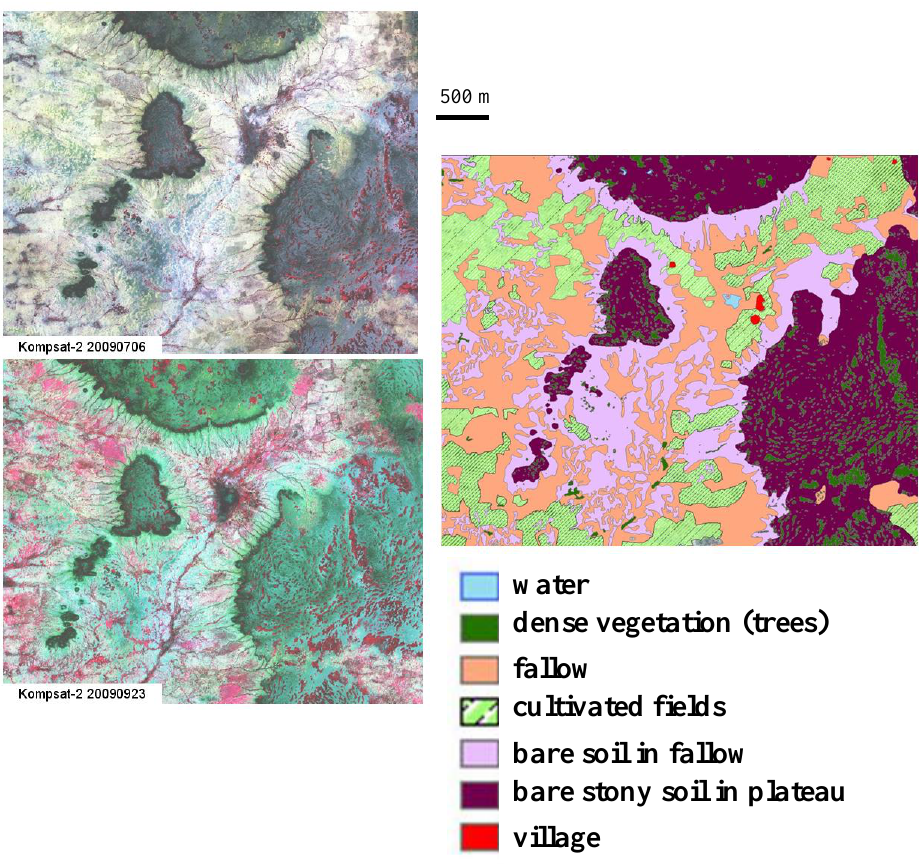
Figure 4. Illustration of landuse/landcover conditions in 2009 on Banizoumbou (on a segment of Kompsat